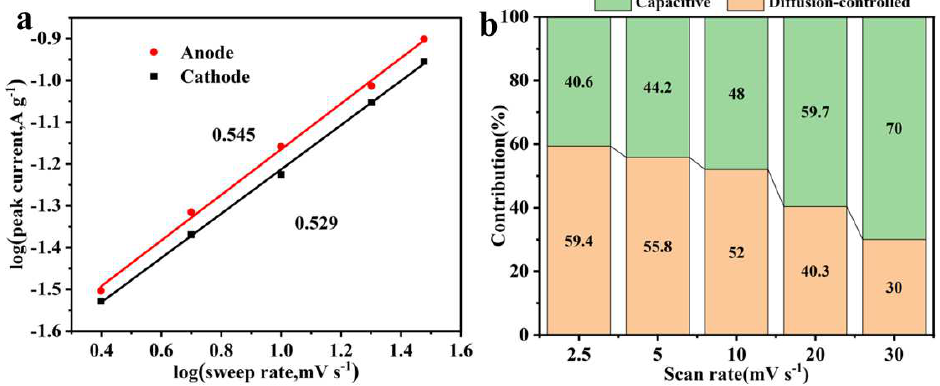
Figure 7. The law between log( v ) and log( i p ) of CNFs@Ni(OH) 2 /NiO-250 electrode ( a ). Bar graph of capacitance contribution at various scan rates ( b ).